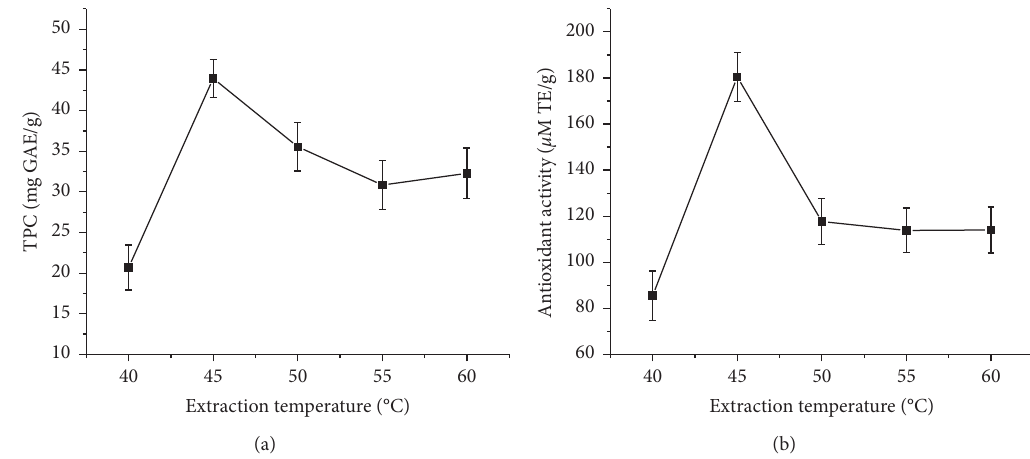
Figure 3: Effect of extraction temperature ( ° C) on the (a) TPC (mg GAE/g) and (b) antioxidant activity ( μ M TE/g) of the extract.